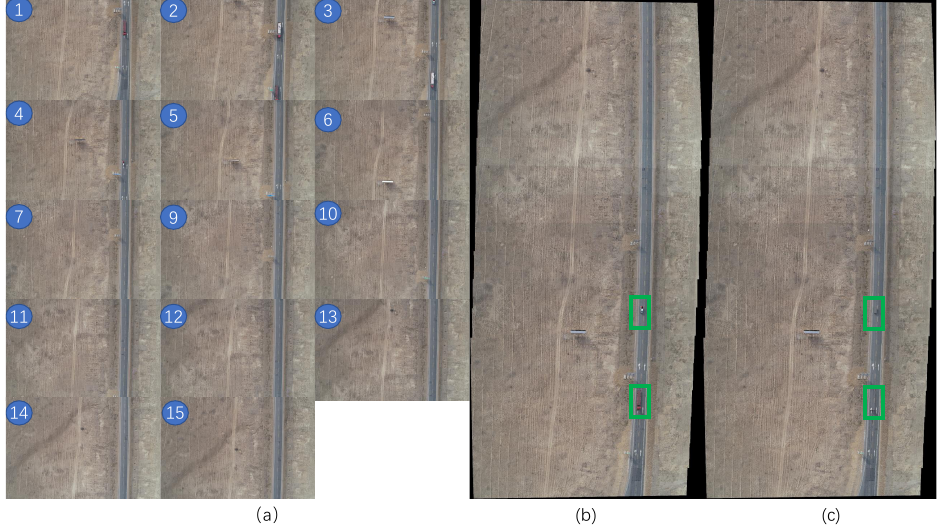
Figure 6. Image Stitching. ( a ) Images to be stitched, ( b ) stitched by Equations (5), ( c ) stitched by Equation (6). The number in the blue circle indicates the order of